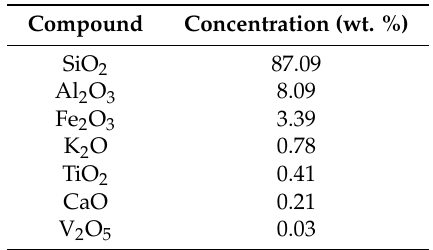
Table 1. Chemical composition of natural Wakkanai Siliceous Shale